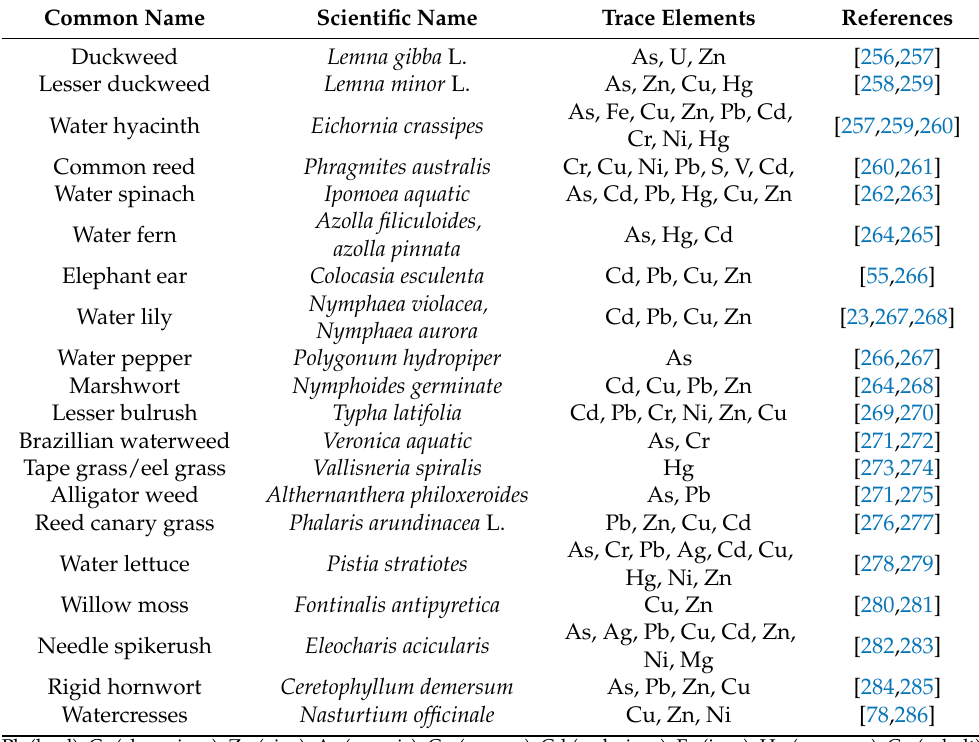
Table 3. Heavy metal uptake by macrophytes testified in the